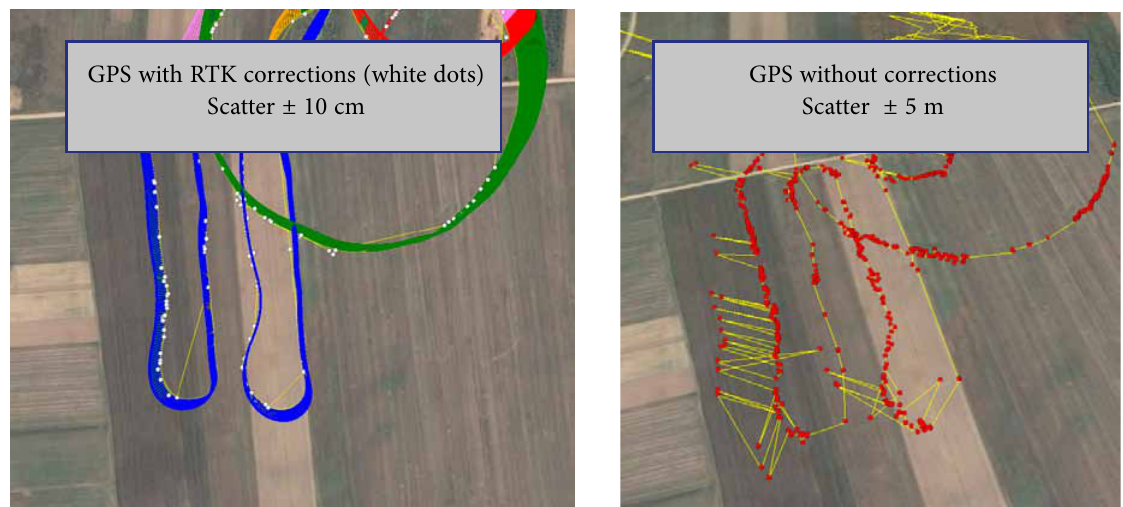
Fig. 5. The same UAV trajectory flight with 2 different GPS receivers (source: figures made by the authors)